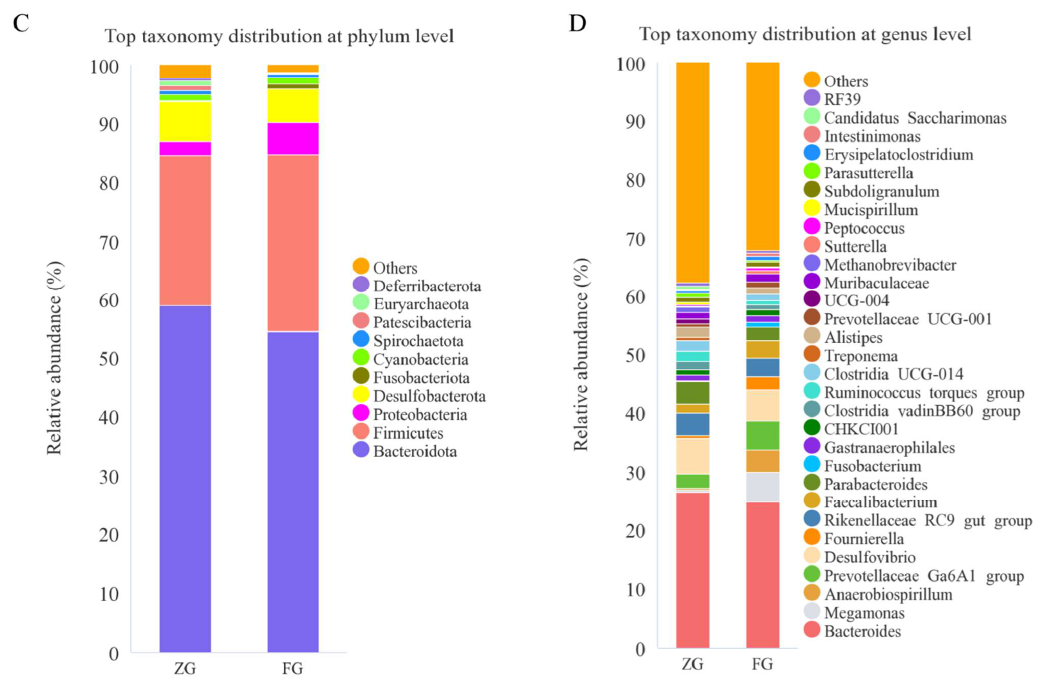
Figure 3. Differences in the cecal microbial composition between the two goose breeds. ( A ) Principal coordinate analysis (PCoA) plot showing cecal microbial compositional differences as quantified by ( B ) Bray–Curtis distance; ( C , D ) taxonomic compositions; n = 5. *** p < 0.001 and **** p < 0.0001 indicate significant differences between the ZG and FG. ZG, Zi goose; FG, Xianghai flying goose.